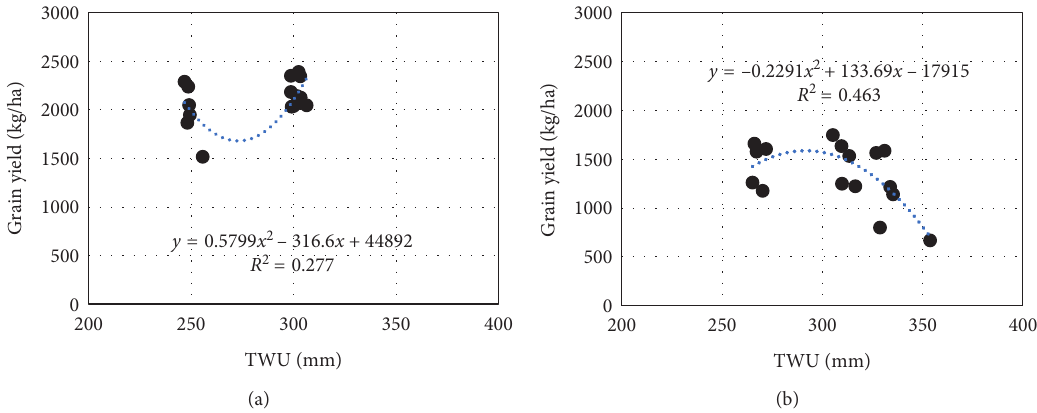
Figure 2: Quadratic relationship between total water use (TWU) and grain yield (GY) of pearl millet in Minjibir and Gambawa sites. Each data point represents mean grain yield and TWU across N-fertilizer rates over two growing seasons (2014 and 2015). (a) Minjibir and (b) Gambawa.